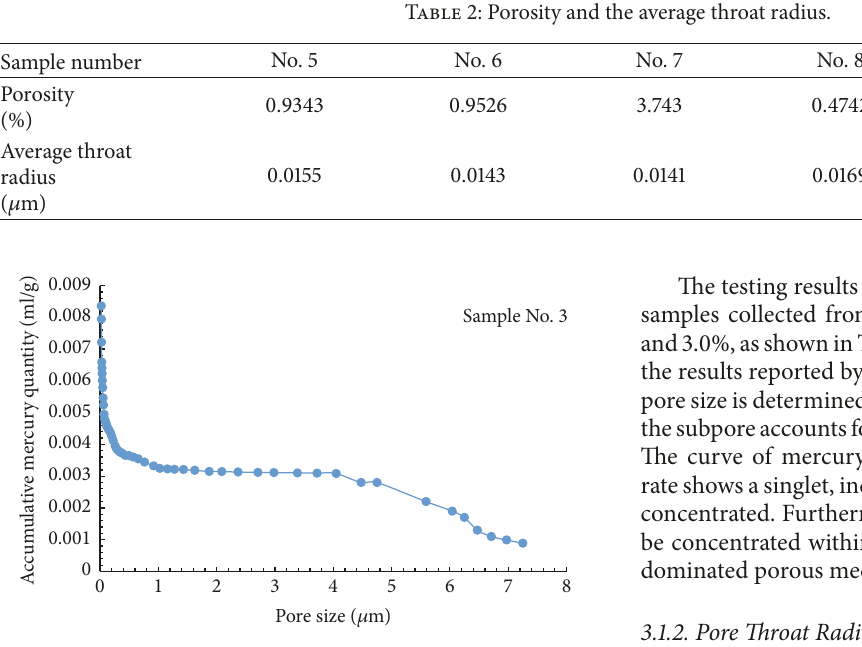
Figure 2: Accumulative mercury quantity versus pore size curve of Sample No.